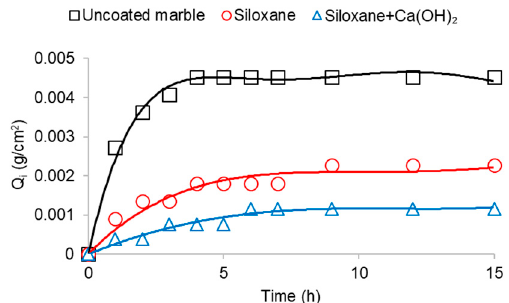
Figure 4. Amounts of absorbed water per unit area (Q i ) as a function of treatment time t i , for three samples: (i) uncoated marble; (ii) marble coated by pure siloxane; and (iii) marble coated by a